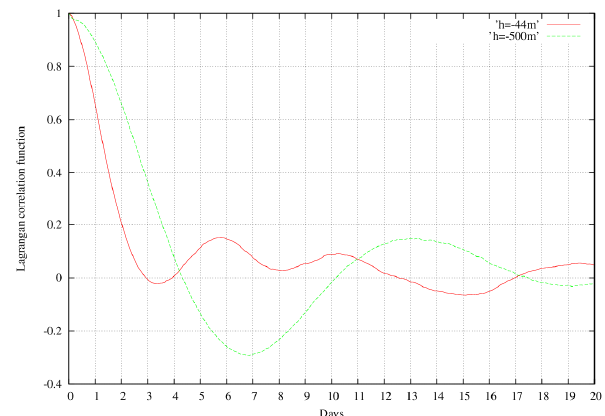
Fig. 7. Temporal evolution of the Lagrangian correlation function at depths 44 and 500m.